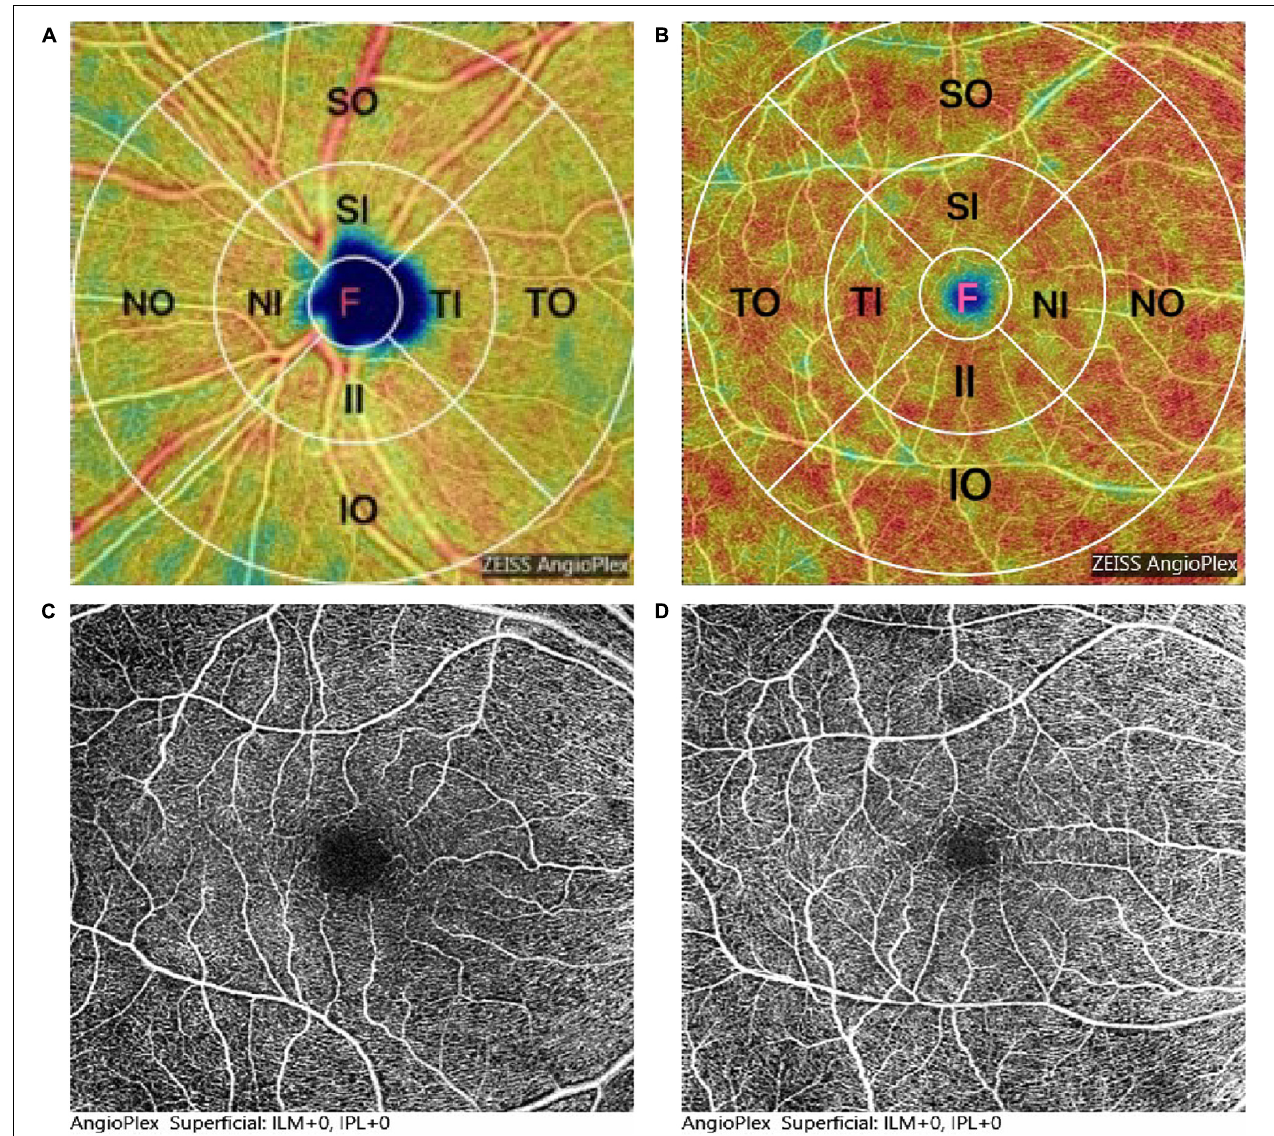
FIGURE 1 | Representation of optical coherence tomography angiography (OCTA) image and measurement of the density analysis of the superficial retinal capillary plexus (SCP). (A,B) Map of macular and peripapillary, 1 mm central circle, representing the center area, and inner and outer rings of diameters 3 and 6 mm, respectively. The inner and outer rings were divided into four quadrants: superior, nasal, inferior, and temporal. (C,D) Foveal avascular zone (FAZ) area was significantly decreased in patients with Parkinson’s disease (PD) (D) compared to healthy controls (HC) (C)